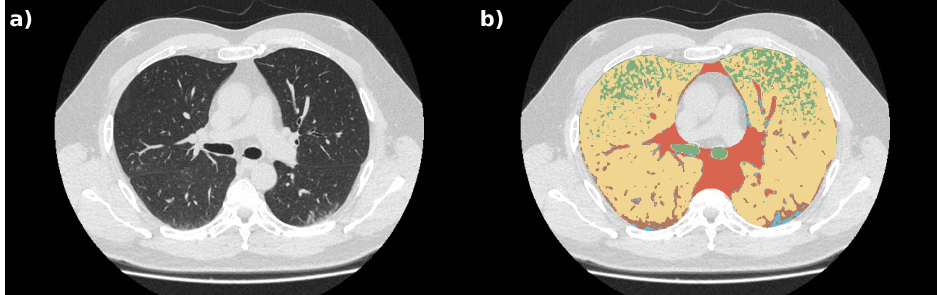
Figure 3. Exemplary axial view of an anatomical image (panel ( a )) and labeled volume (panel ( b )) extracted from patient 17 (S = 1). The green label represents air, the yellow label marks healthy lungs, the light blue label indicates ground glass opacity (GGO), brown voxels are consolidations, and orange clusters are other denser